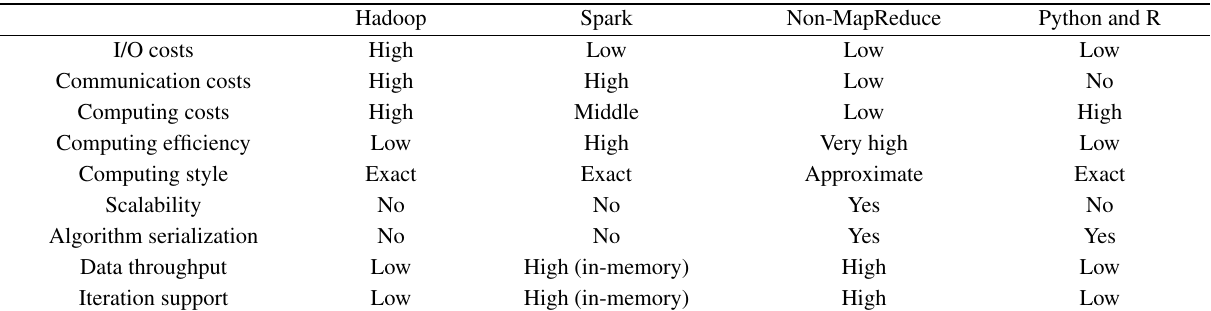
Table 1 Evaluations of computing frameworks for big data